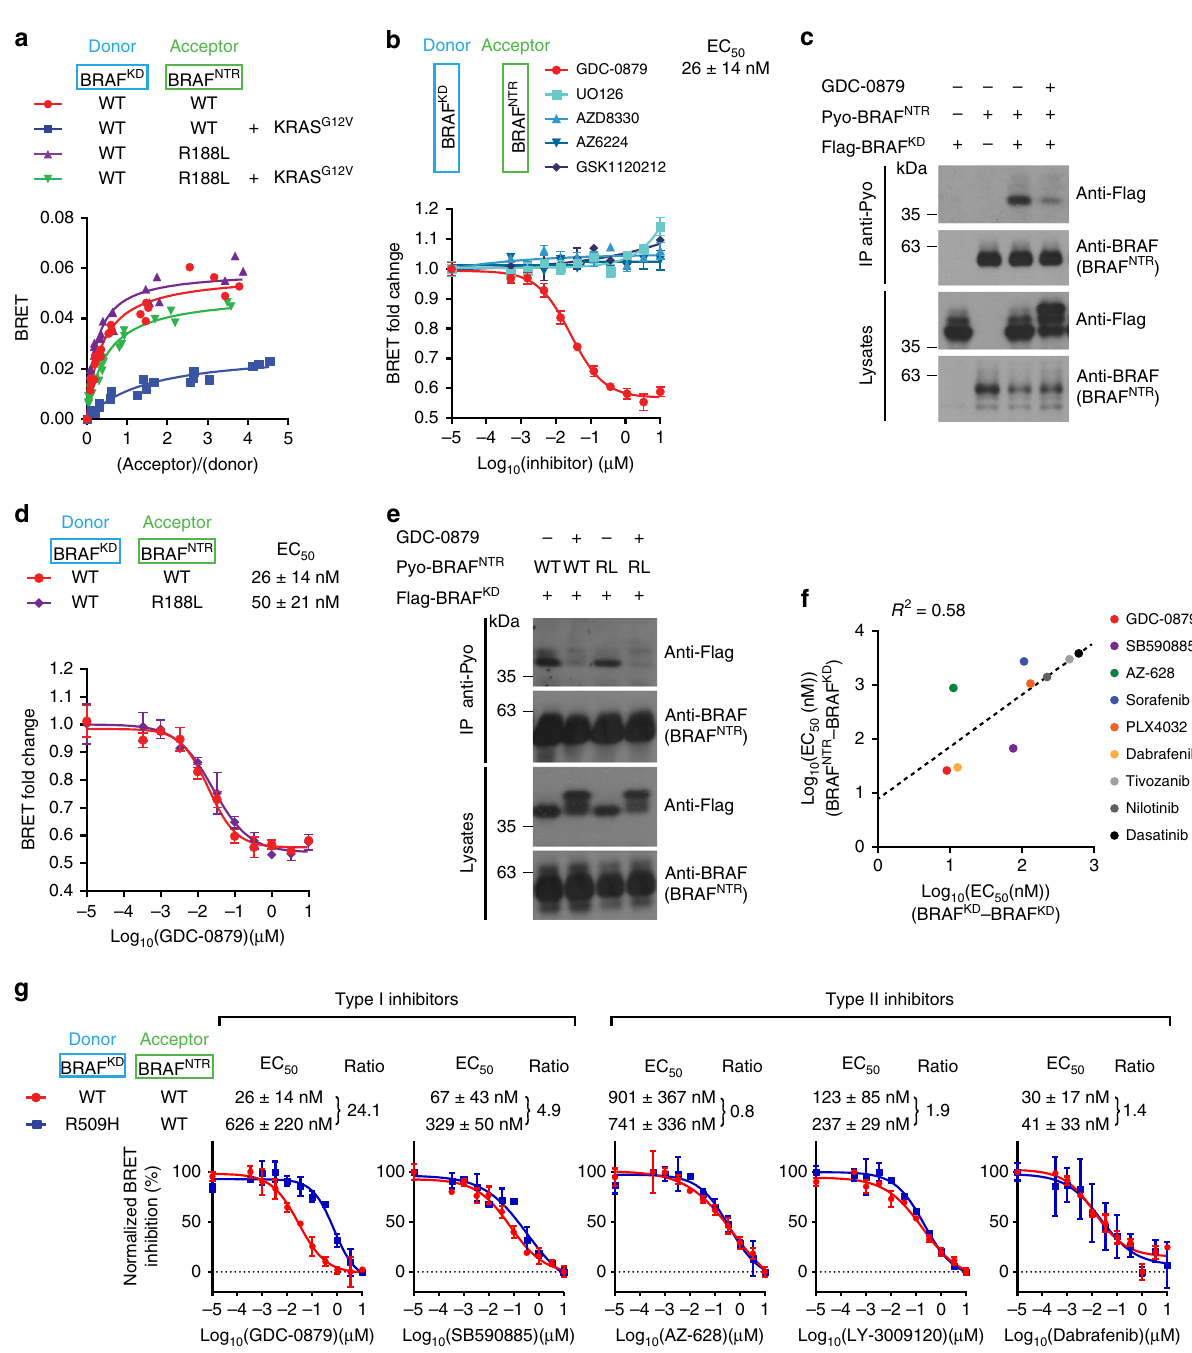
Fig. 3 RAF ON-state inhibitors disrupt BRAF intramolecular interaction in a RAS-independent manner. a BRET titration curves demonstrating the speci fi city of BRAF intramolecular biosensors (BRAF NTR − BRAF KD ). Addition of mCherry-KRAS G12V robustly impaired the BRAF NTR-KD association, whereas a probe containing the BRAF NTR _R188L mutant was insensitive to activated RAS. b Dose-response analysis of the BRAF NTR − BRAF KD BRET probes with the RAF inhibitor GDC-0879 and a series of MEK inhibitors. c GDC-0879 disrupted the BRAF NTR − BRAF KD complex in co-IP experiments. Anti-BRAF was used to detect the expression of Pyo-tagged BRAF NTR . BRET d and co-IP e show that GDC-0879 equally disrupts the interaction of the BRAF kinase domain with either WT or R188L (RL)-mutated NTR constructs. f Correlation between inhibitor-induced BRAF kinase domain dimerization and the disruption of BRAF NTR-KD interaction. EC 50 s for each inhibitor in the BRAF-BRAF kinase domain dimerization assay were plotted against EC 50 s obtained with the BRAF NTR - BRAF KD BRET assay. g The dimerization-impaired mutant BRAF R509H impedes BRAF NTR − BRAF KD disruption induced by type I inhibitors, but does not signi fi cantly impede disruption induced by type II inhibitors. GDC-0879 was used at 1 µ M in all co-IP experiments. EC 50 s are the average of at least three independent replicates (Supplementary Figs. 3a, 4g; Supplementary Data 1). To facilitate comparison between conditions, the range between minimal and maximal BRET signals was normalized to 100% in g . Error bars in dose-response curves correspond to mean values ± s.d. of technical duplicates of a representative biological triplicate. EC 50 s are the average of at least three independent repeats (Supplementary Data